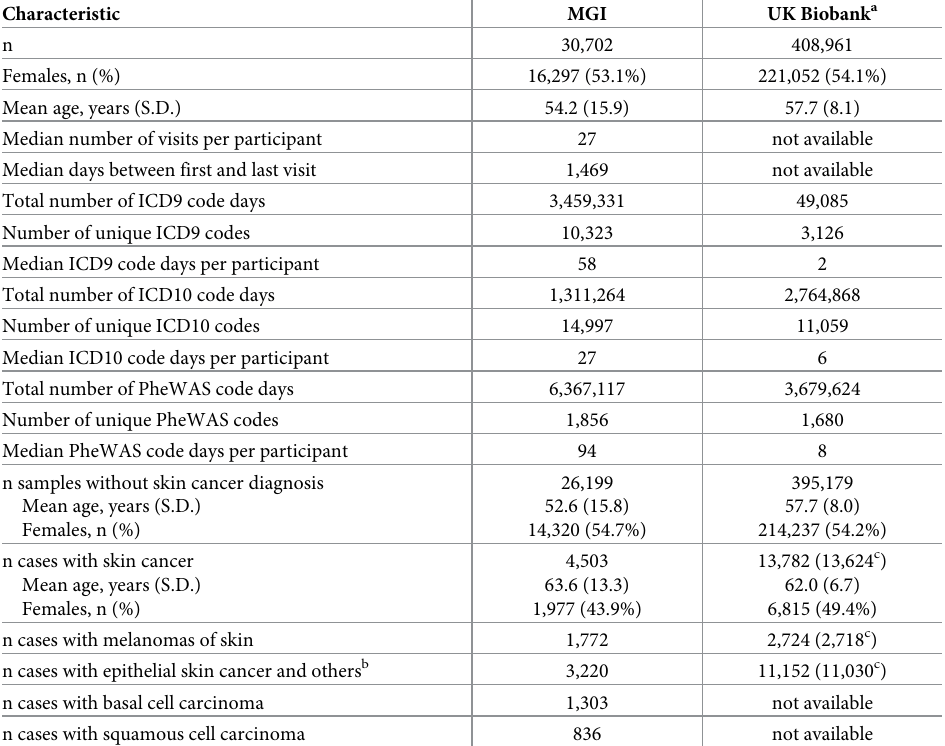
Table 1. Demographics and clinical characteristics of the analytic datasets. Characteristic MGI UK Biobank a n 30,702 408,961 Females, n (%) 16,297 (53.1%) 221,052 (54.1%) Mean age, years (S.D.) 54.2 (15.9) 57.7 (8.1) Median number of visits per participant 27 not available Median days between first and last visit 1,469 not available